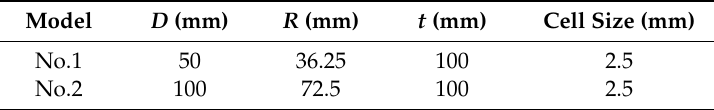
Table 1. Detailed information about the